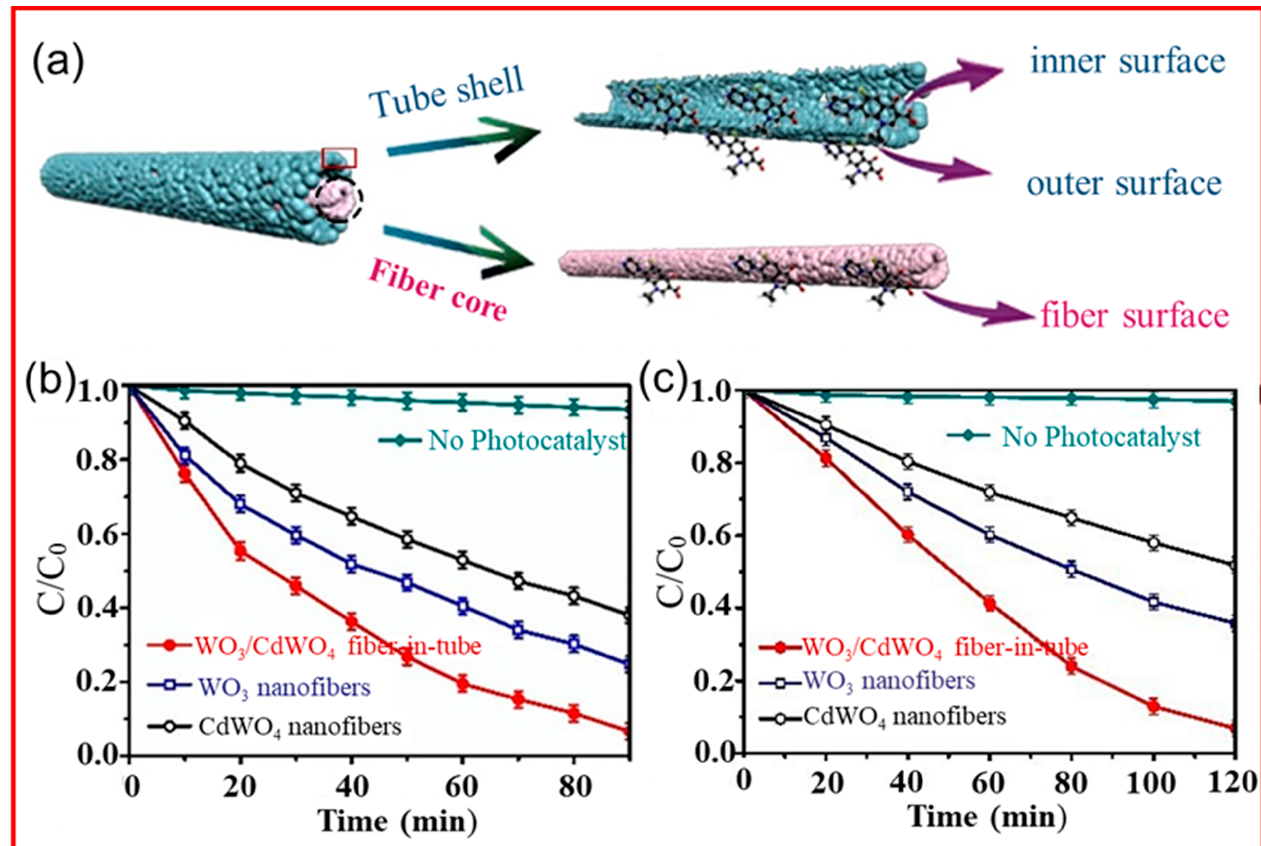
Figure 11. ( a ) Illustration of layered porous WO 3 /CdWO 4 FITNs showing the three surfaces of CIP adsorption and catalytic sites; photocatalytic degradation efficiency of WO 3 , CdWO 4 and WO 3 /CdWO 4 FITNs for ( b ) CIP and ( c ) TC at room temperature [152].